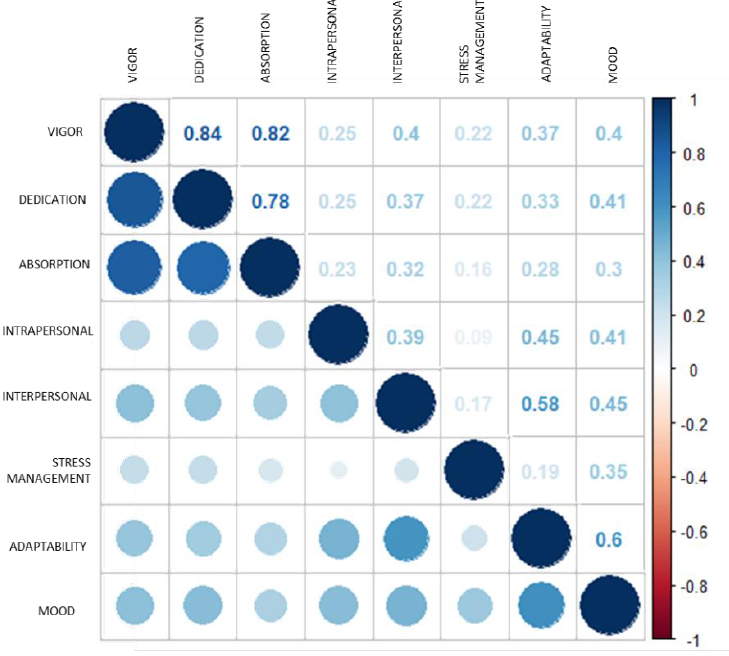
Figure 1. Components of emotional intelligence and engagement. Correlation matrix.